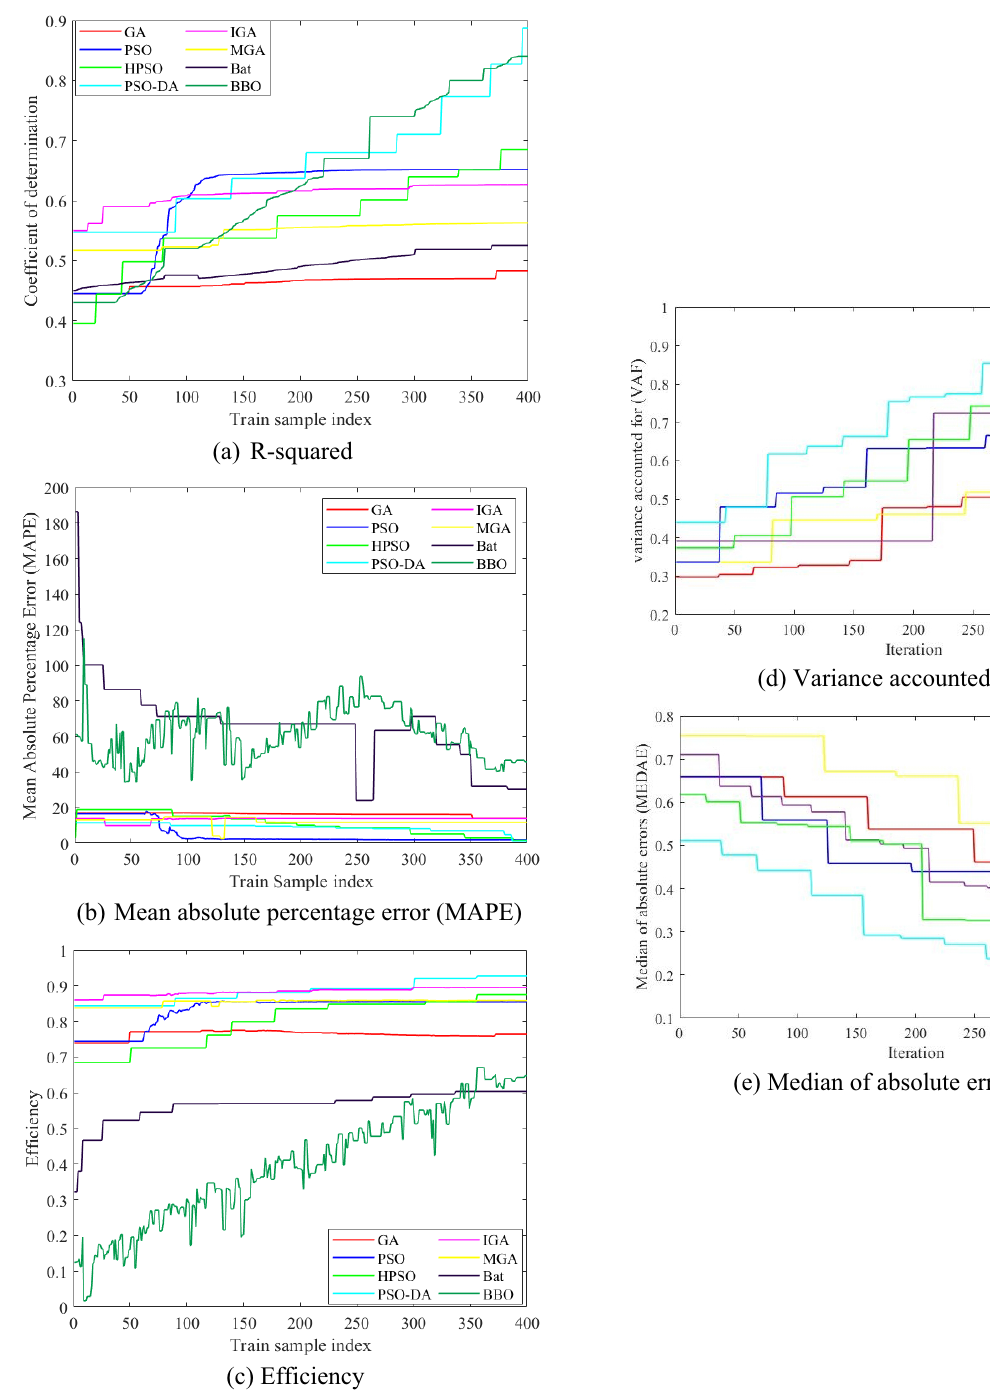
Fig. 15 Results for training dataset over 400